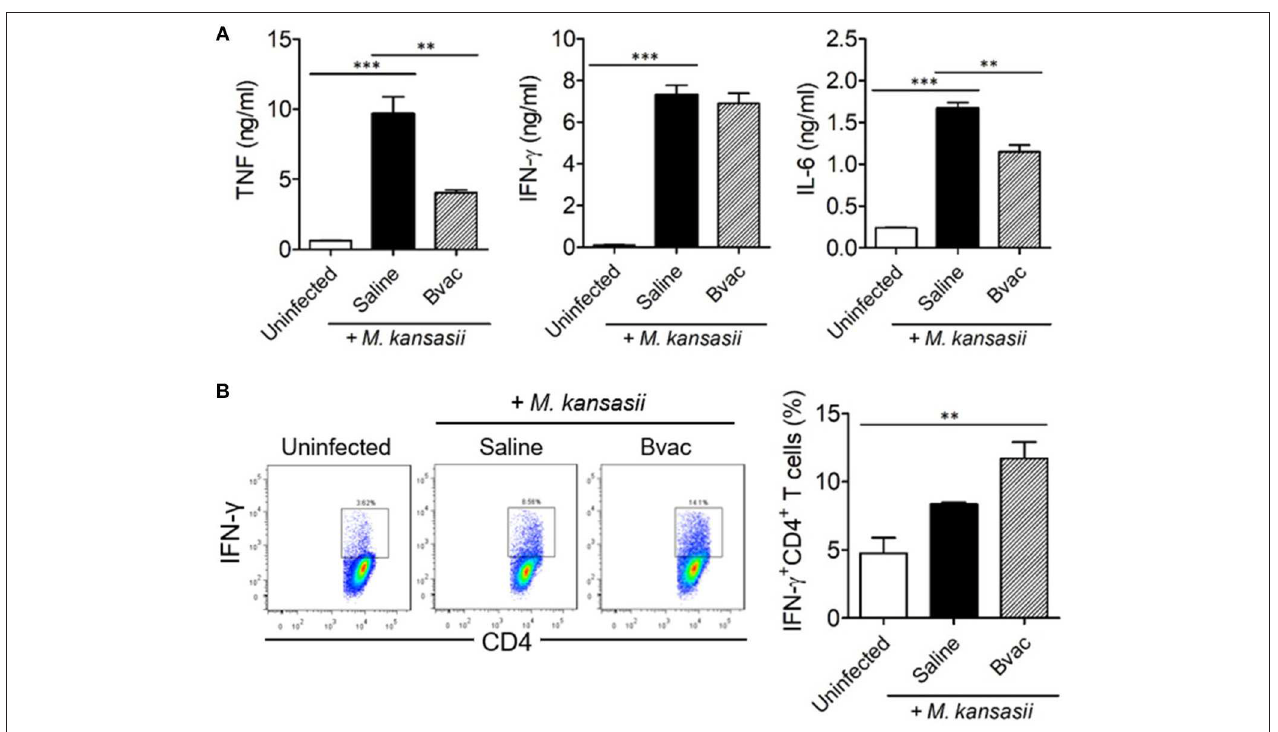
FIGURE 5 | Therapeutic administration of Bvac increased the production of IFN- γ in CD4 + T cells in M. kansasii -infected mice. Mice were infected with 10 7 CFU/mouse of M. kansasii , and then they were intravenously injected with Bvac at day 3 and 7 post infection. After 14 days following M. kansasii infection, lung and spleen were isolated to analyze cytokine production. (A) The levels of TNF, IFN- γ , and IL-6 from lung homogenates. (B) Splenic CD4 + T cells were analyzed for IFN- γ production after in vitro stimulation with plate-coated anti-CD3 and anti-CD28 antibodies. Representative histogram (left) and summary (right) for the percentages of IFN- γ producing CD4 + T cells. ANOVA. ** p < 0.01, *** p <